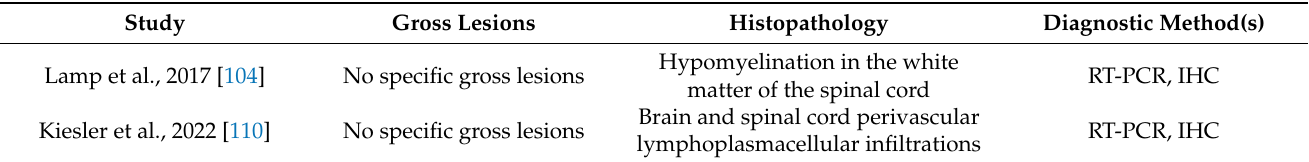
Table 3. Scientific studies describing the gross and histological lesions and diagnostic methods applied for Linda virus